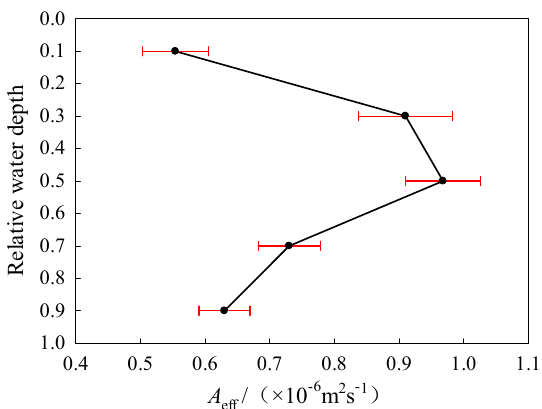
Figure 11. Time-averaged vertical profile of effective thermal diffusivity in late winter.